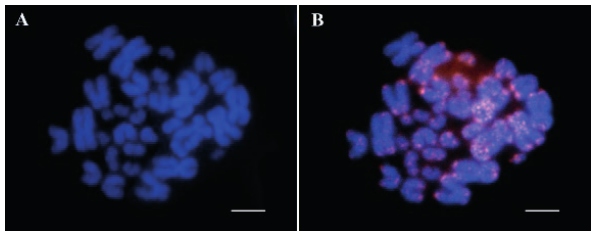
Figure 5. Metaphase chromosome plate of G. petricolus ( A ) by FISH technique of DAPI ( B ) microsatellite probe (GC) 15 . Scale Bars = 10